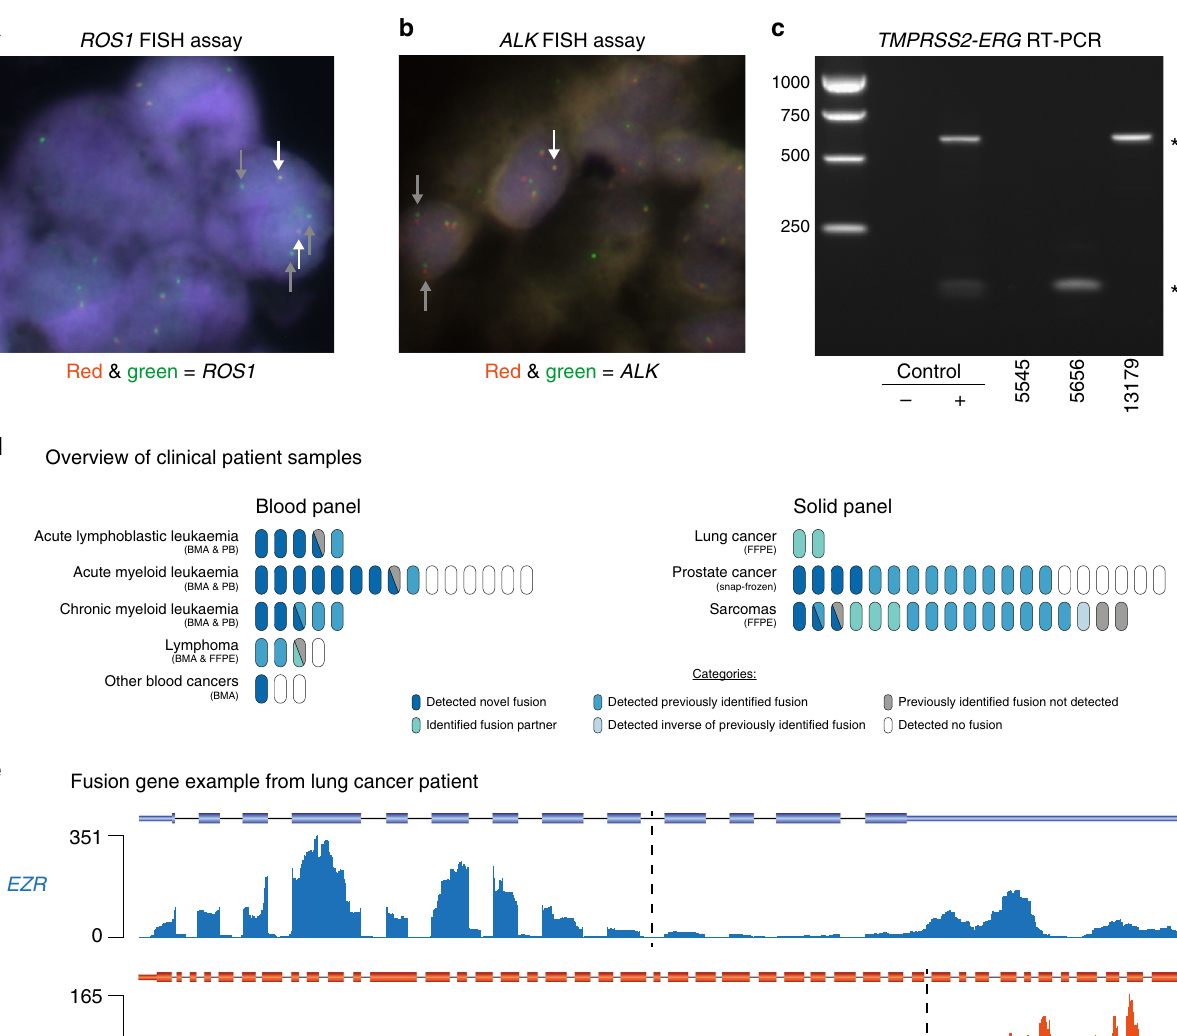
Fig. 3 Fusion identi fi cation in clinical cohort samples. a FISH identi fi cation of ROS1 rearrangement in lung cancer sample MO-16-000393. Positive signal is 1 fused set of red and green dots and ≥ 1 isolated green dots per cell. White arrows point to fused dots; grey arrows point to green dots. b FISH identi fi cation of ALK rearrangement in lung cancer sample SP-15-11000. Positive signal is 1 fused set of red and green dots, 1 isolated red and 1 isolated green dot per cell. White arrows point to fused dots; grey arrows point to isolated red and green dots. c RT-PCR analysis to diagnose TMPRSS2-ERG fusion genes in prostate samples. * indicates TMPRSS2-ERG bands. Source data are provided as a Source Data fi le. d Overview of fusion gene identi fi cation in all clinical cohort samples; each oval represents one patient. Other blood cancers includes chronic lymphocytic leukaemia, multiple myeloma and uncategorised blood cancer patients. BMA = bone marrow aspirate; PB = peripheral blood; FFPE = formalin- fi xed paraf fi n-embedded. e Read coverage across EZR and ROS1 genes in lung cancer patient sample MO-16-000393. Dotted line marks fusion junction of EZR-ROS1 fusion